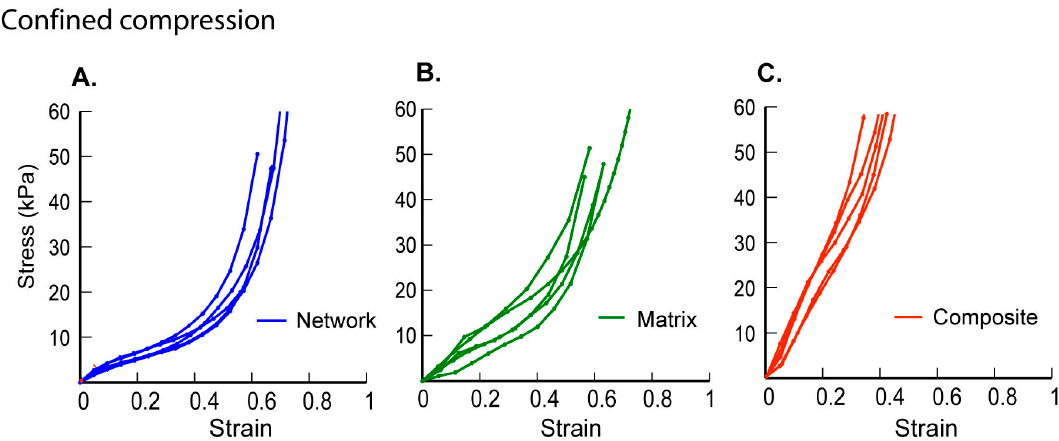
Figure Figure 2. Confined compression results for ( A ) network scaffolds; ( B ) matrix hydrogels; and ( C ) composite scaffolds are shown to characterize the role of water in the overall mechanical response ( n = 5).